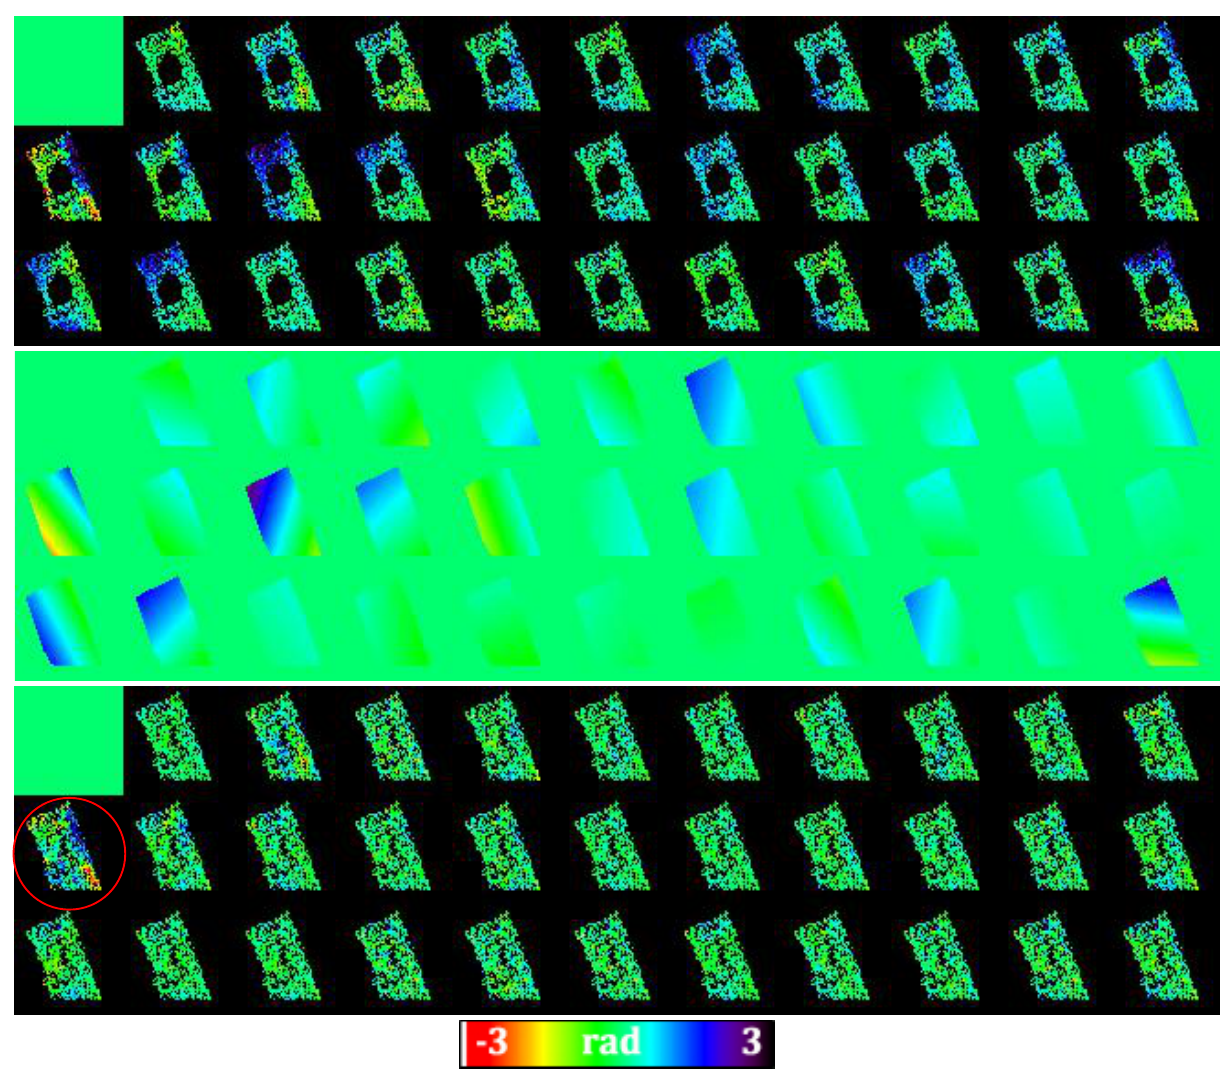
Figure 1. Atmospheric component estimation using a stable area. 33 original phases that cover an area of approximately 16 km 2 (top). The black circles show the study area (1 km radius, approximately). Linear atmospheric components (middle). Residual phase after removing the linear atmospheric component